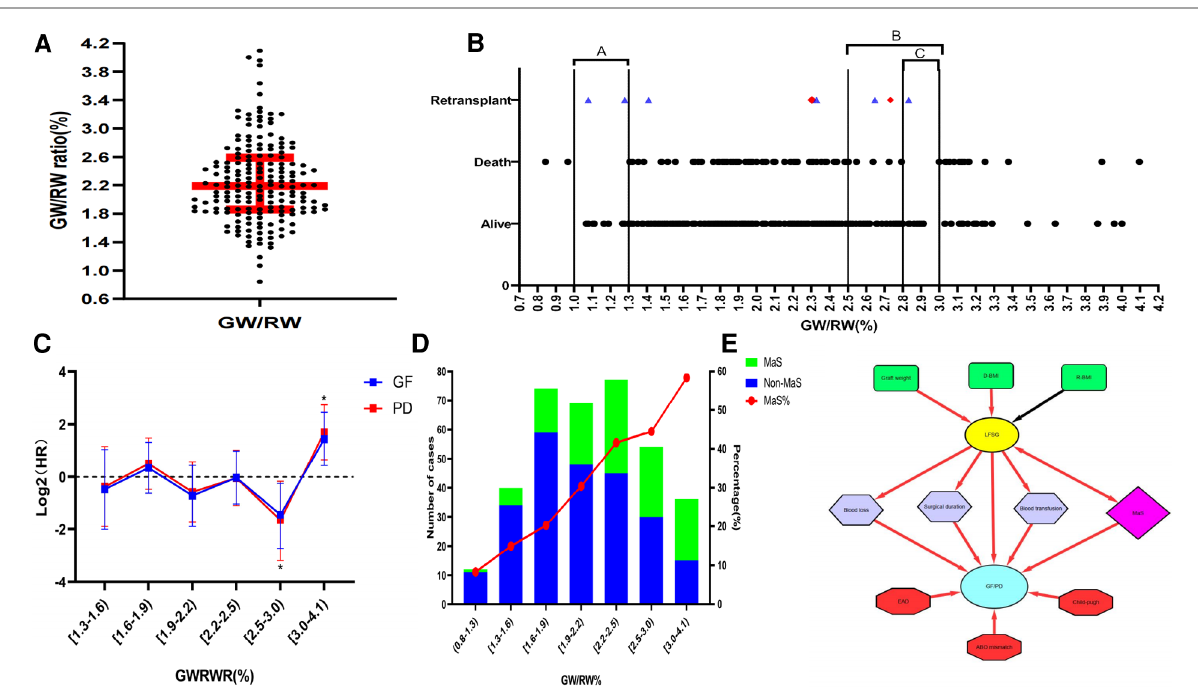
FIGURE 1 Impact of the GWRWR on prognosis by interaction with graft MaS. ( A ) Distribution of the GWRWR for LT cases in the whole cohort; ( B ) scatter diagram on the association between the GWRWR and prognosis; the points marked in red denote fi nal deaths after re-LT during follow-up, and the points marked in blue denote survival during follow-up; ( C ) continuous-adjusted HRs of the GWRWR on the prognosis of patients after LT; HRs were assessed by using the COX regression model by adjusting donor/recipient BMI and graft MaS; *represents signi fi cant differences compared with the other groups; ( D ) correlation between the GWRWR and MaS prevalence; the left Y -axis represents the number of MaS/non- MaS cases, and the right Y -axis represents the percentage of MaS in the corresponding subgroup; ( E ) schematic diagram showing the complex role of LFSGs in the risk pro fi le for poor prognosis after LT; the red line denotes positive correlations on both sides, and the black line denotes negative correlations on both sides. BMI, body mass index; GWRWR, graft weight-to-recipient weight ratio; HR, hazard ratio; LFSG, large-for-size graft; LT, liver transplantation; MaS,